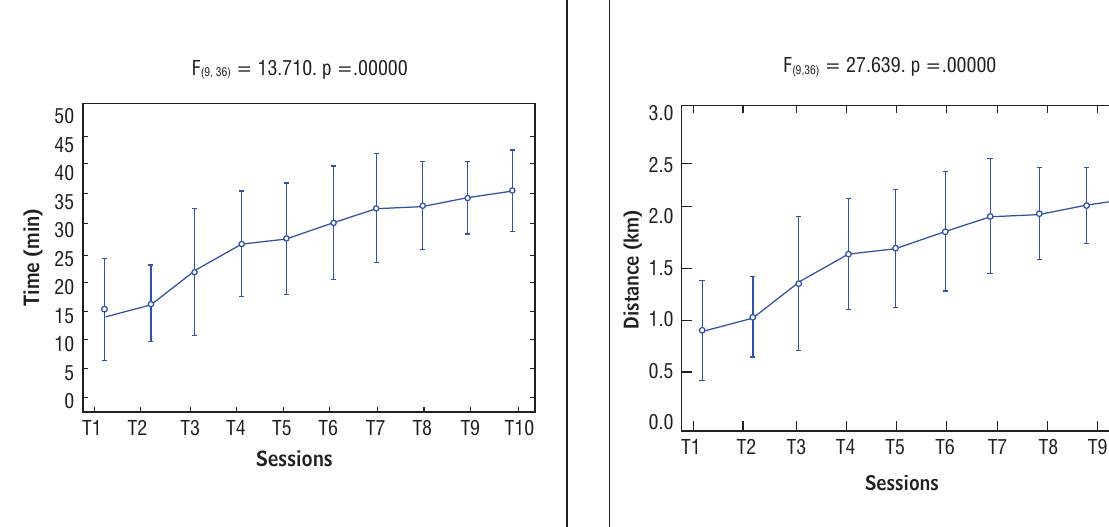
Figure 1 - Mean and confidence intervals of activity time (in minutes) over the course of the 10 sessions